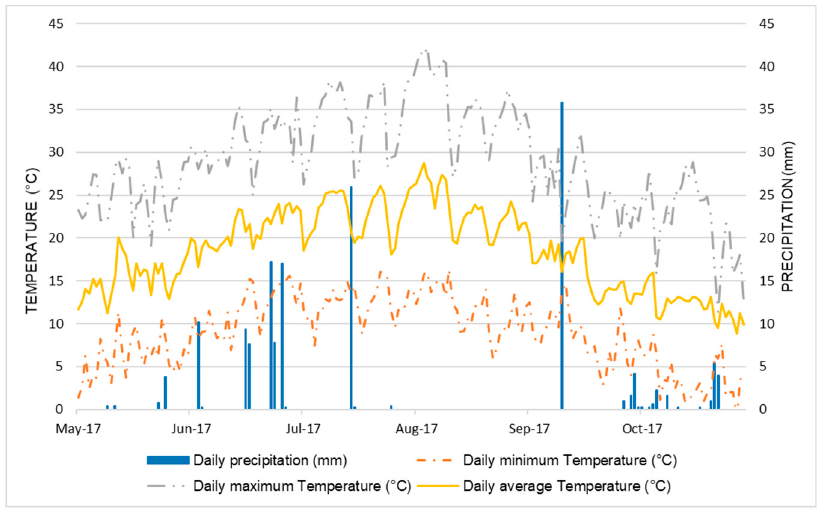
Figure 1. Total precipitation and average temperatures during the bean growing season (May–Oc- tober